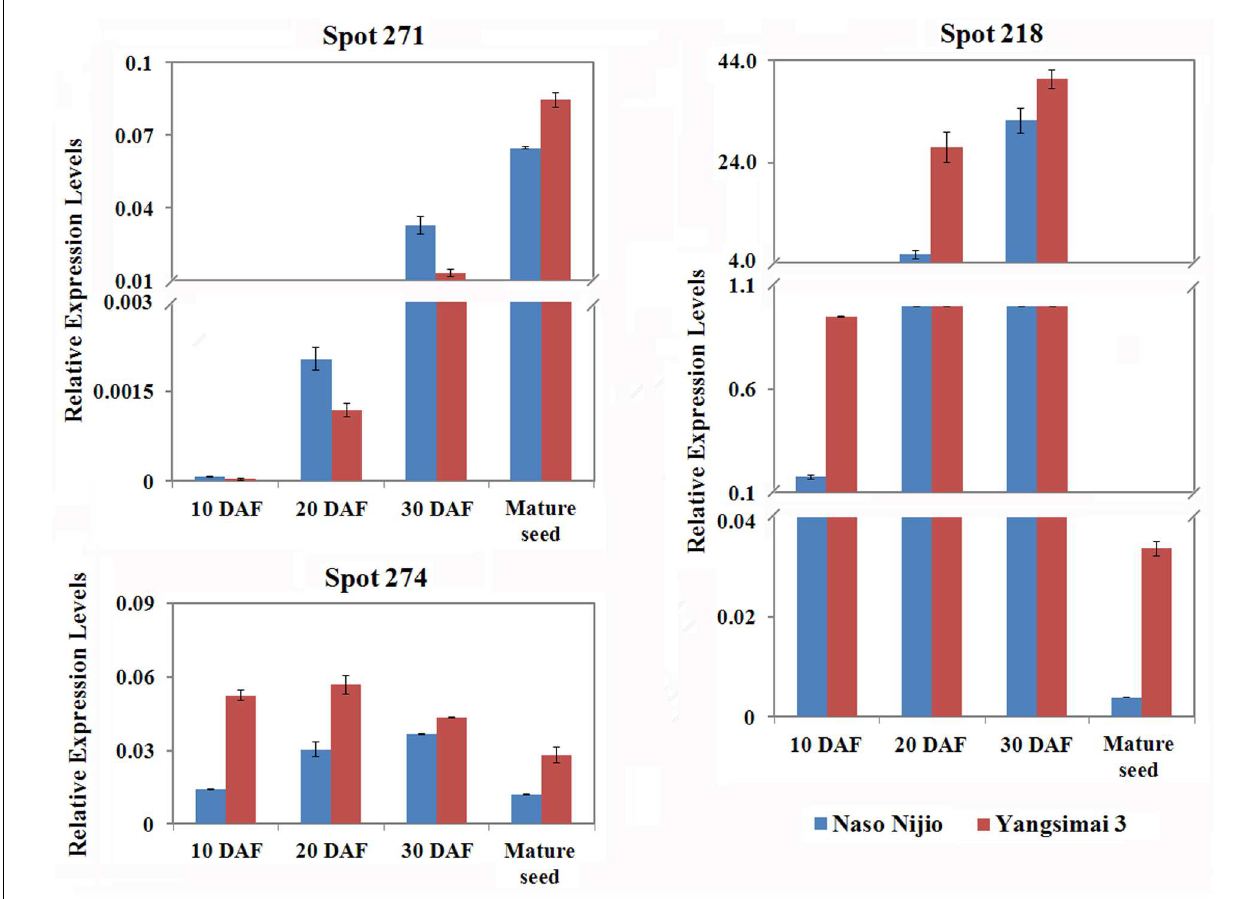
FIGURE 5 | Quantitative real-time PCR of mRNA expression patterns for selected protein spots in 10 DAF (days after flowering), 20 DAF, 30 DAF and mature